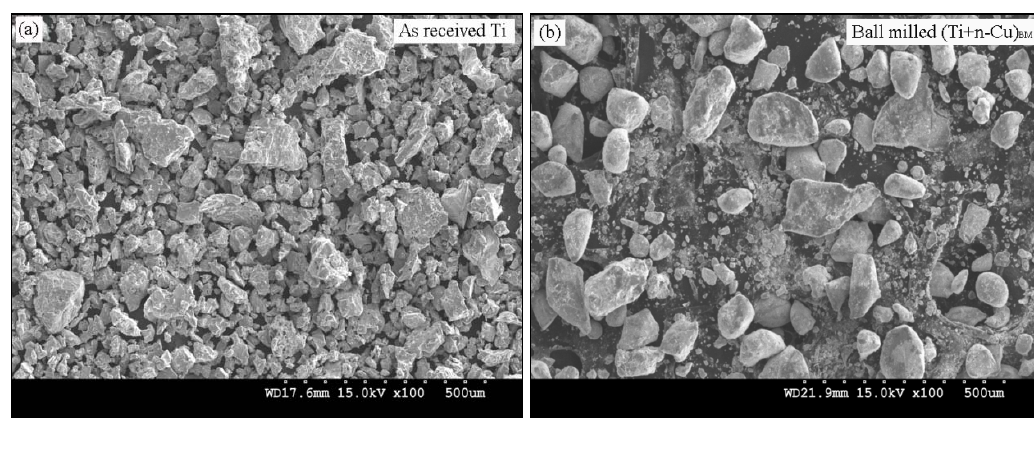
Figure 4. SEM micrographs showing the morphology of ( a ) as-received Ti particulates and ( b ) ball milled (Ti + Cu) powder. BM